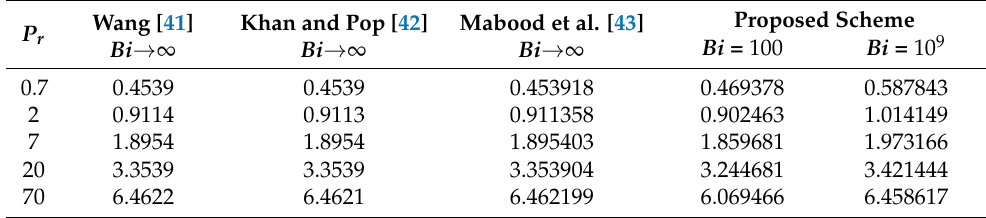
Table 2. Comparison of results obtained by the proposed scheme and by past research for calculation of − θ (cid:48) ( 0 ) using λ = F r = K b = R d = Q =